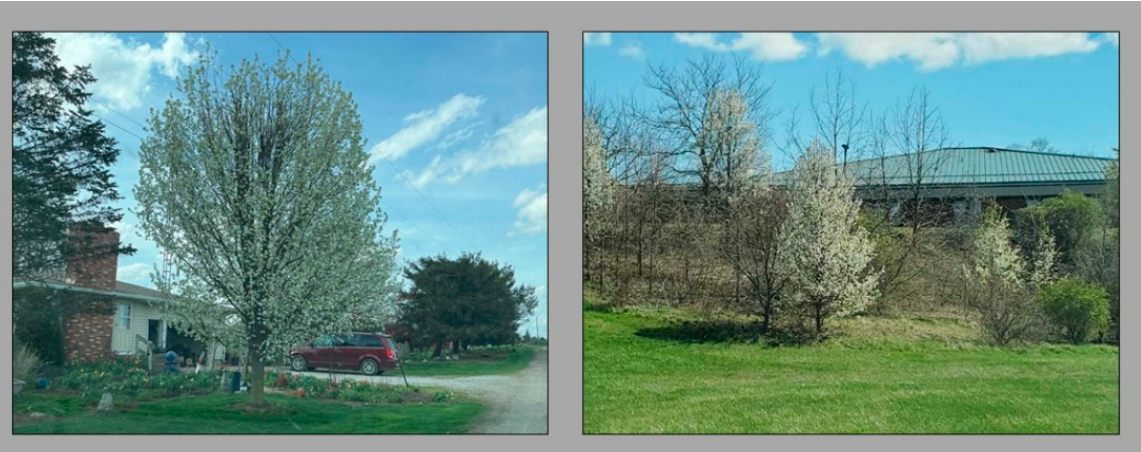
Figure 2. Representative planted ( left ) and feral ( right ) P. calleryana trees from study areas in northern Ohio. Planted trees were in manicured yards, and feral trees were in unmanaged sites and roadsides, sometimes adjacent to, but not part of, manicured yards. P. calleryana is identifiable in these photos by their profuse, white flowers.